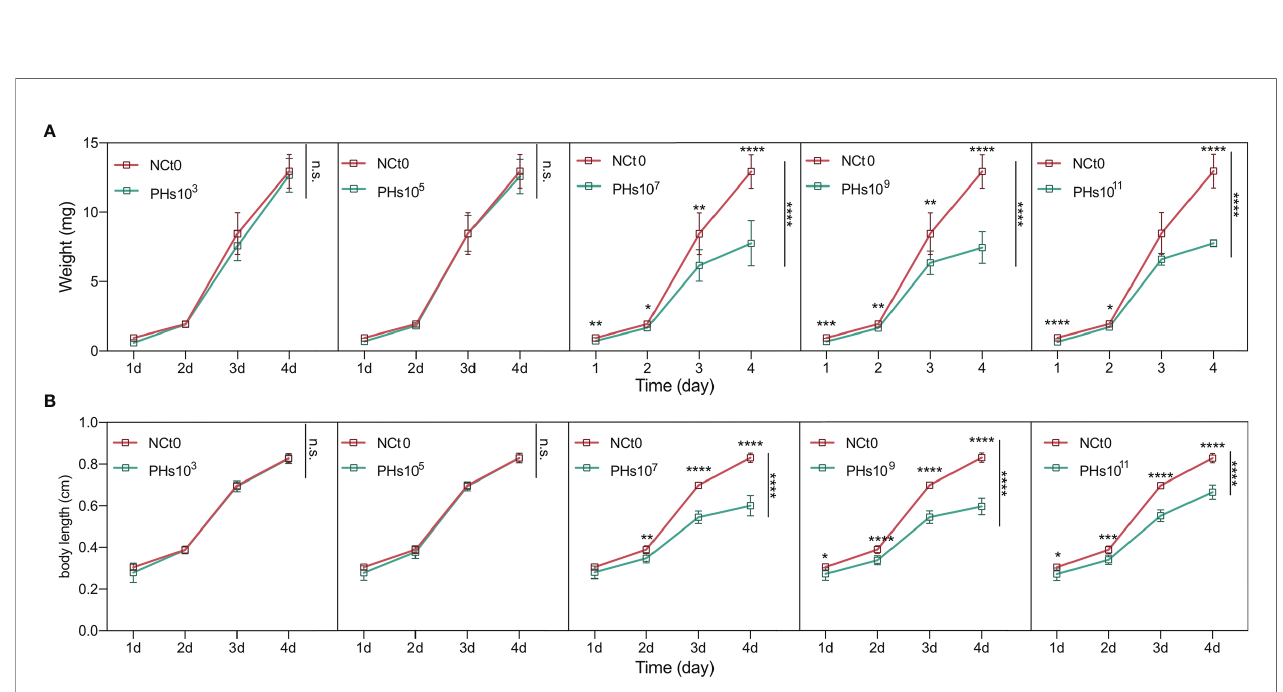
FIGURE 2 | A neighbor-joining phylogenetic tree showing the relatedness of phage Phc to similar phages for which data are publicly available from the NCBI. A neighbor-joining phylogenetic tree based on terminase small subunit protein similarity between the phage used in this experiment (red color) and other similar phages for which data are publicly available from the NCBI (black color). The Phc belonged to the order Caudovirales and the family Drexlerviridae subfamily Tempevirinae and was highly similar to Enterobacter phage Ec_L1 (GenBank accession: NC_042122.1). The scale bar represents 0.050 amino acid substitutions per site, and values next to the nodes show bootstrap values based on 500 samples.